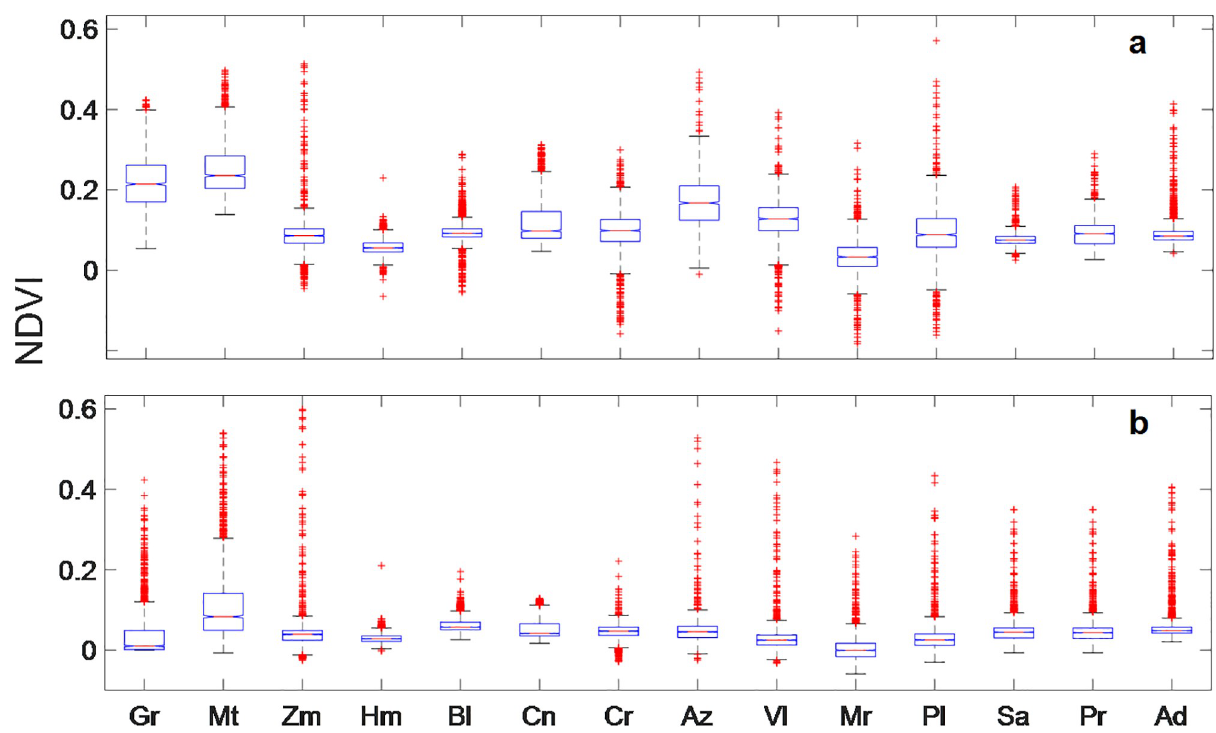
Fig 3. Comparison of NDVI values at waterholes detected during a) wet season (November to February), and b) dry season (May to July) in Sierra Santa Isabel, Baja California, Mexico. Gr = Grande, Mt = Matomi, Zm = Zamora, Hm = Hemes, Bl = Blancas, Cn = Canelo, Cr = Cordero, Az = Zamora, Vl = Volca´n, Mr = Miramar = Pl = Palmito, Sa = San Agustı´n, Pr = Peralta, Ad =